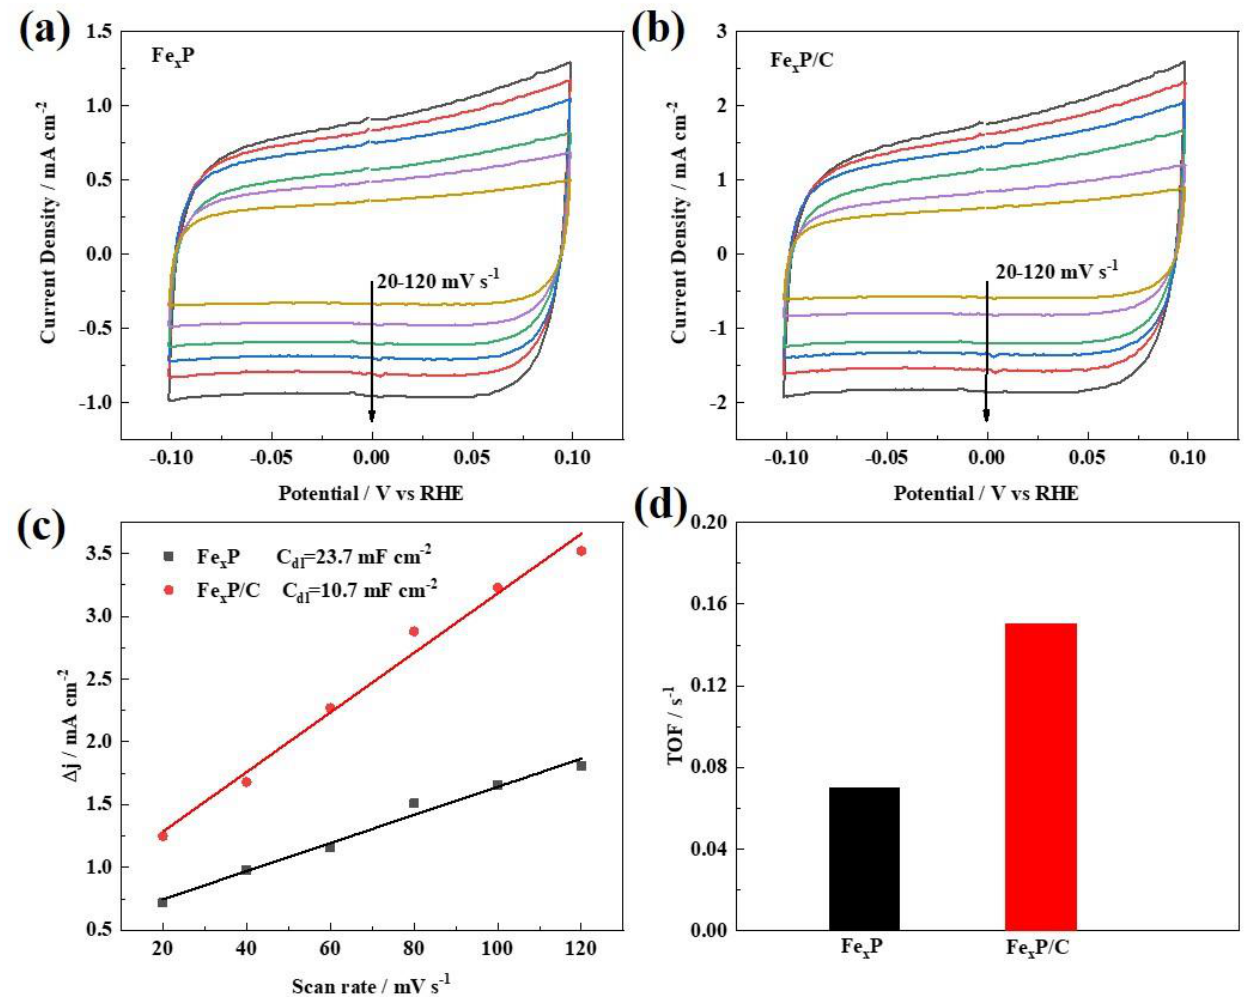
Figure 5. CV curves of ( a ) Fe x P and ( b ) Fe x P/C in non-Faradaic region at various scan rates; ( c ) CV current density versus scan rate plot; and ( d ) TOF plot for Fe x P and Fe x P/C under an overpotential of 150 mV.